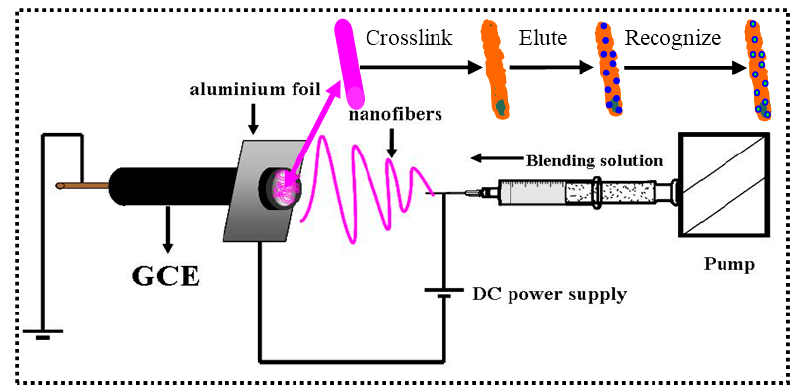
Figure 1. Schematic illustration of the fabrication of INS.